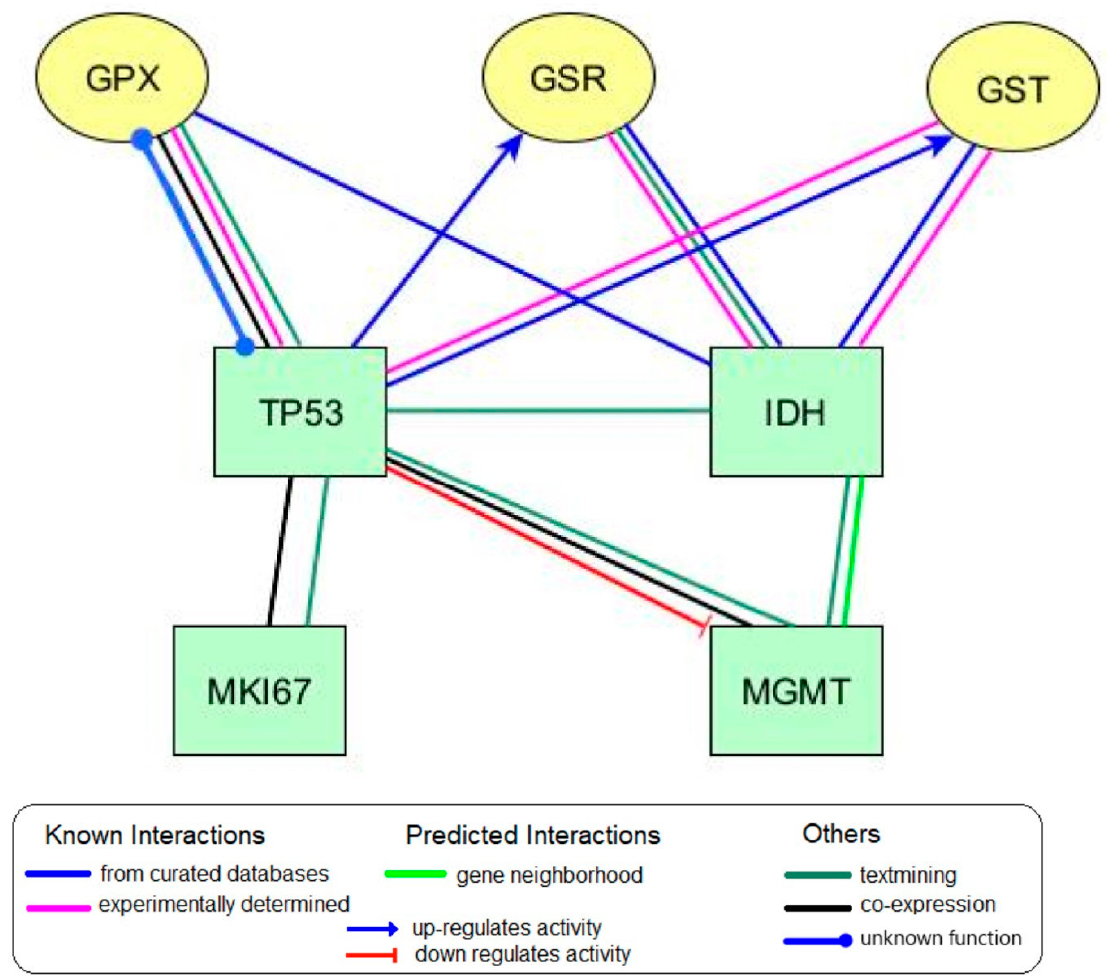
Figure 2. Integrated diagram of protein-protein interactions of immunohistochemical glioma on- comarkers with glutathione metabolism enzymes as per BioGrid, STRING, Signor, and SignaLink databases, using yEd Graph Editor software.